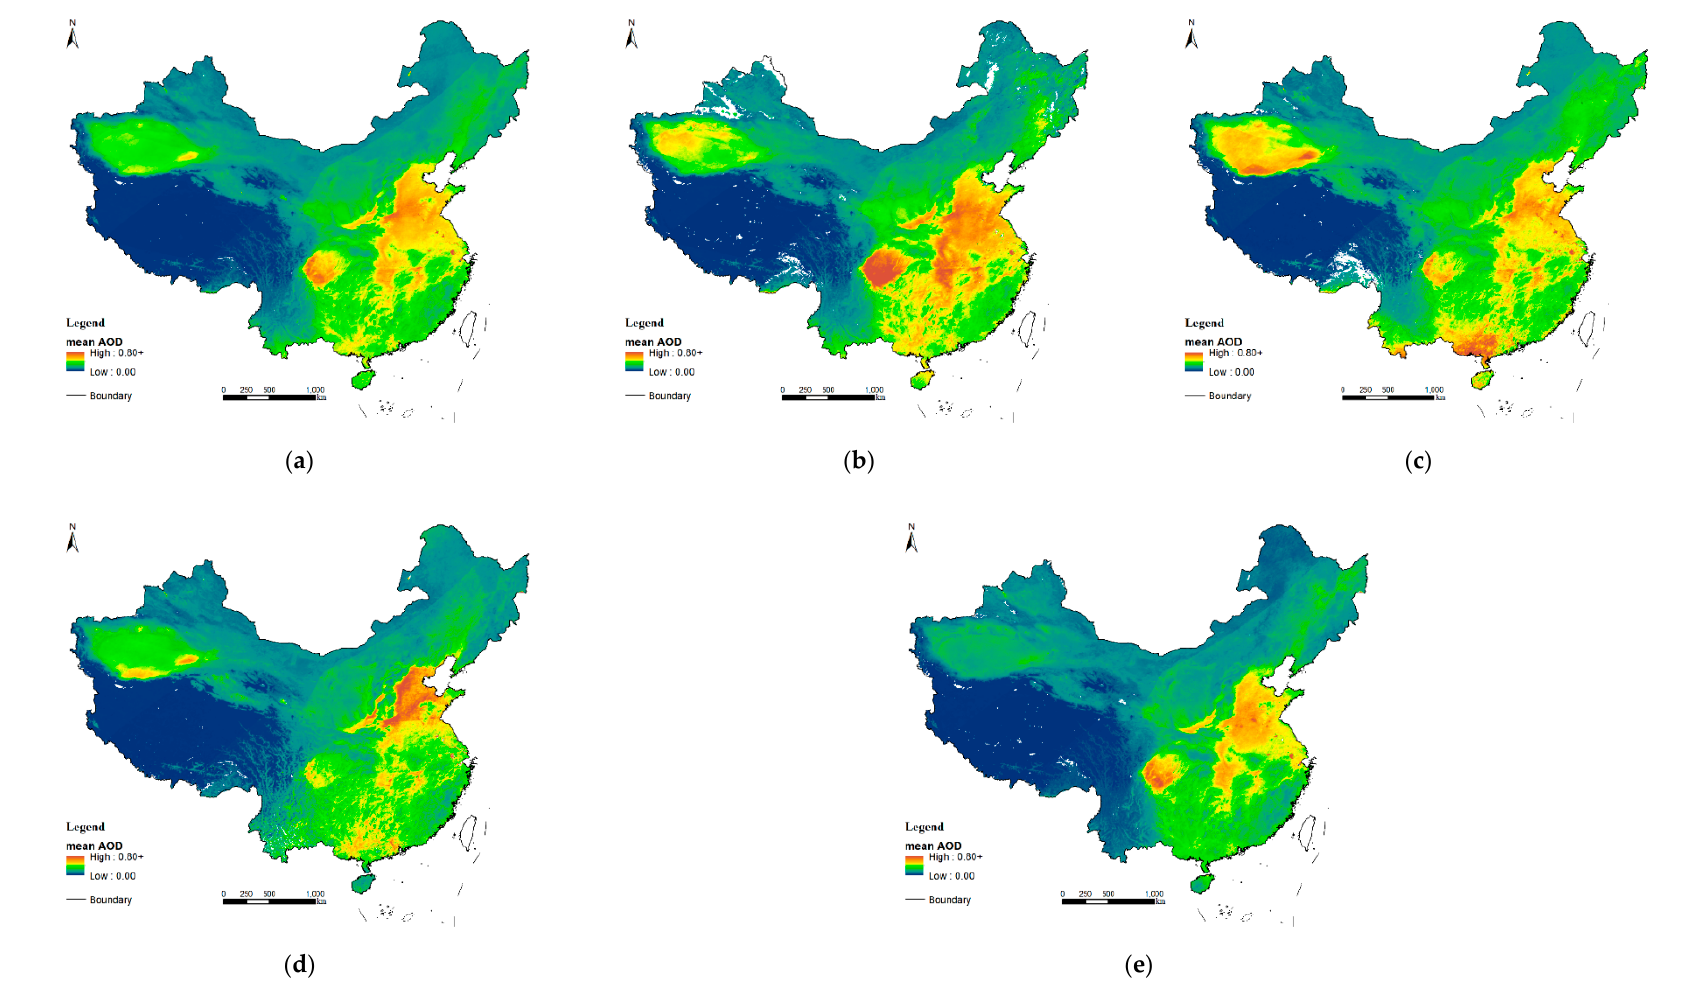
Figure 2. Overall mean distribution of 2015–2018 AOD ( a ) and seasonal mean distributions ( b ) for spring, ( c ) for summer, ( d ) for autumn and ( e ) for winter of AOD from 2015 to 2018.